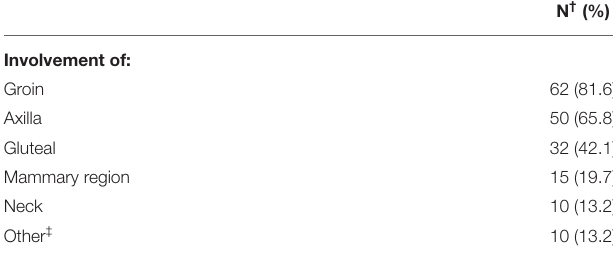
TABLE 1 | Socio-demographic and clinical characteristics of 77 patients with Hidradenitis